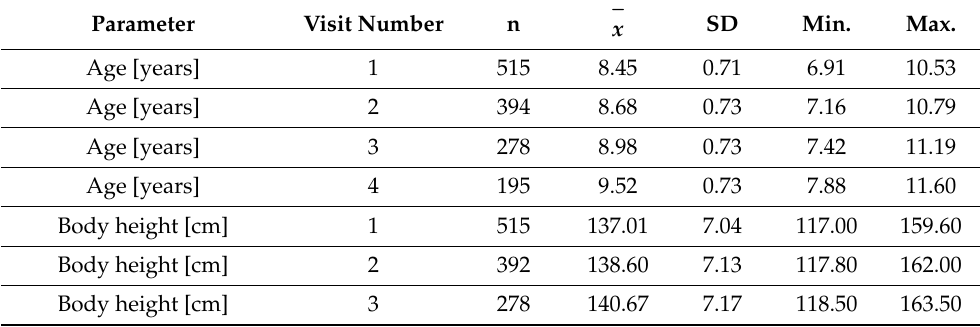
Table 1. Auxological data of the study